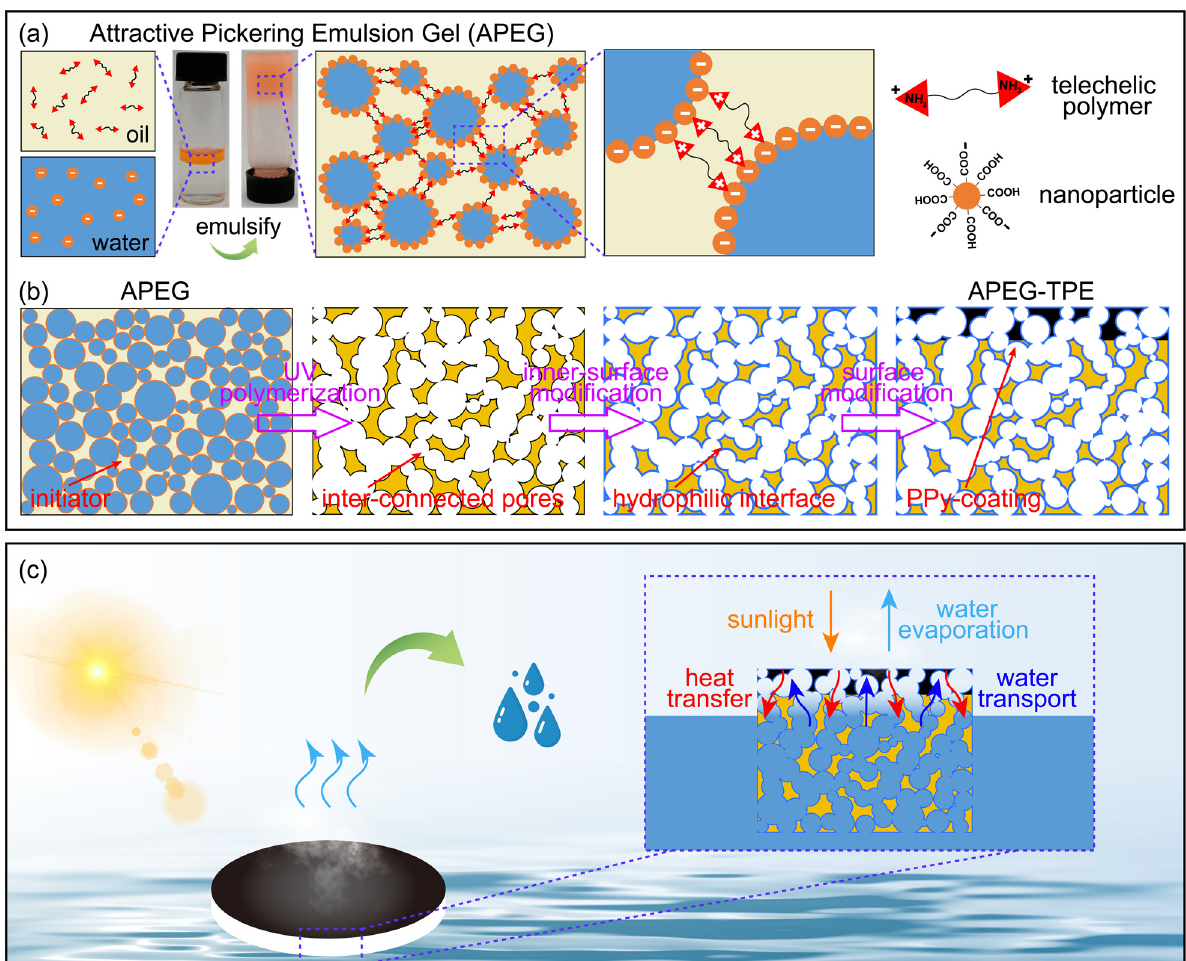
Figure 1. Attractive Pickering emulsion gel-templated porous evaporators (APEG-TPEs) for water distillation using solar energy. ( a ) Preparation of APEGs by bridging neighboring droplets using telechelic polymers via electrostatic interaction. ( b ) Preparation of APEG-TPEs through UV polymerization, inner-surface modification and surface modification. Hydrophilization and polypyrrole-coating are successively conducted to construct integrated APEG-TPEs for solar vapor generation. ( c ) Schematic illustration of water distillation using solar energy via APEG-TPEs.